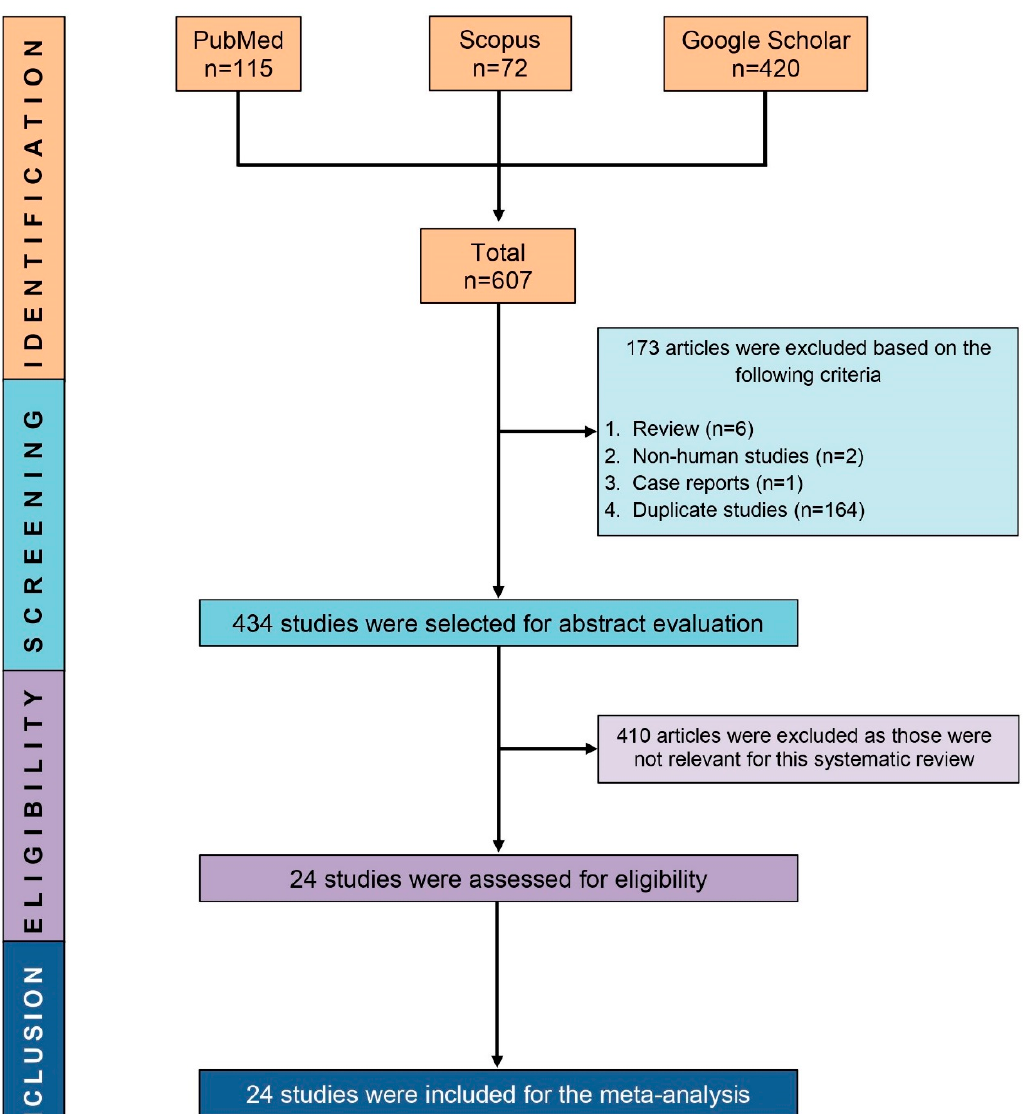
Figure 1. PRISMA flow diagram showing the process of selecting eligible studies.